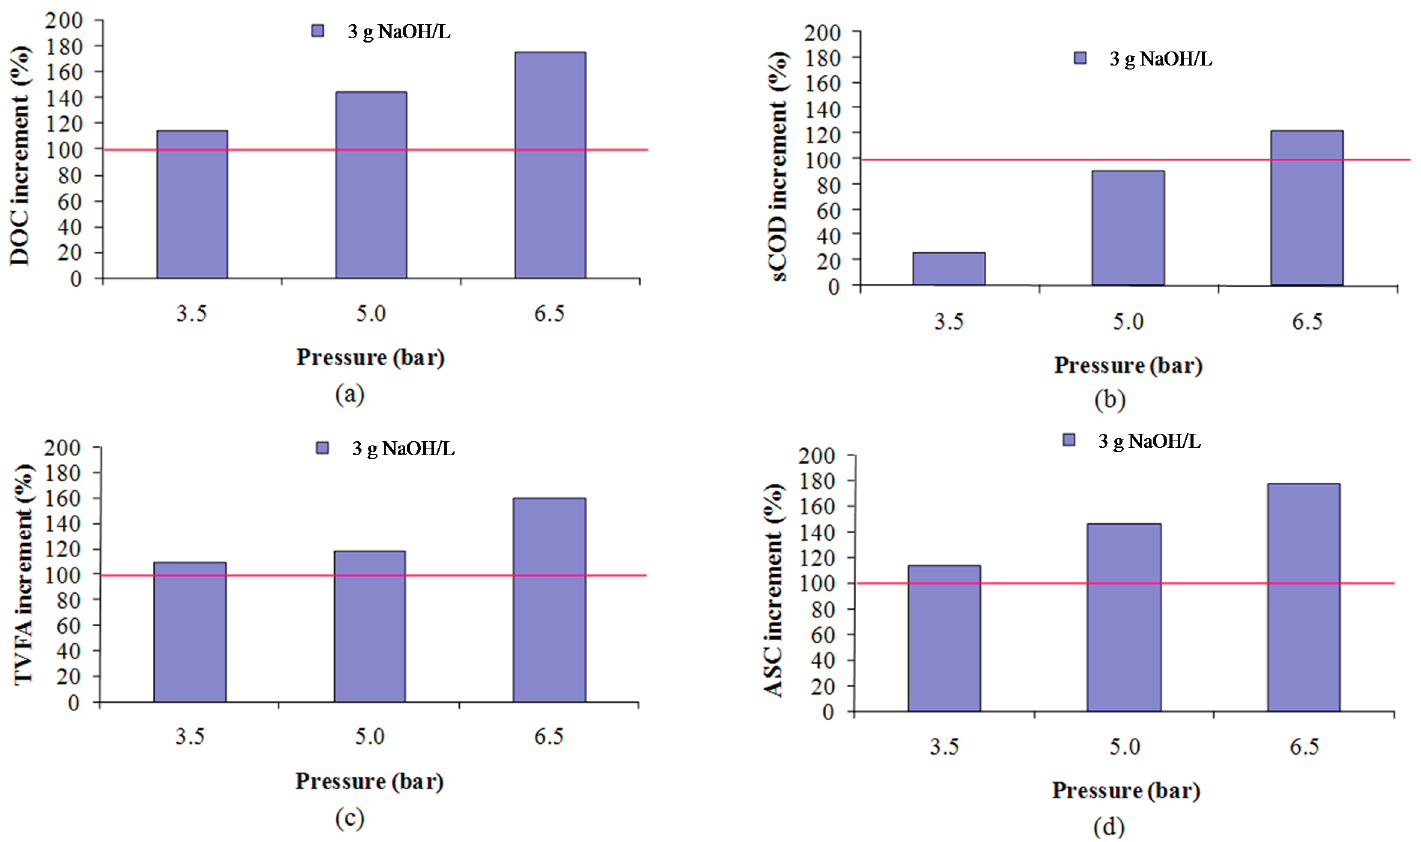
Figure 3. Effect of the pressure on the SY, expressed in terms of DOC ( a ); sCOD ( b ); TVFA ( c ) and ASC ( d ), at 160 °C, 3 g NaOH/L and 30-min operation